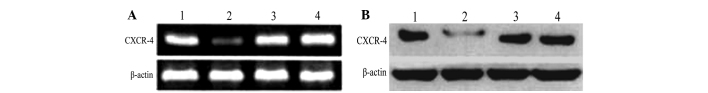
(A) mRNA and (B) protein expression of CXCR-4 in 239T cells by RNA interference. 1, pGCsi-CXCR4-1/ShRNA; 2, pGCsi-CXCR4-2/ShRNA; 3, negative control; and 4, blank control. CXCR4, CXC chemokine receptor 4.